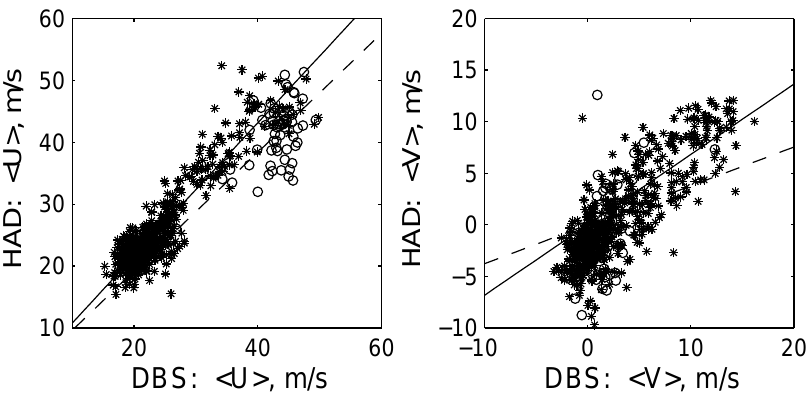
D E U : s =1.08, e =2.96m/s.